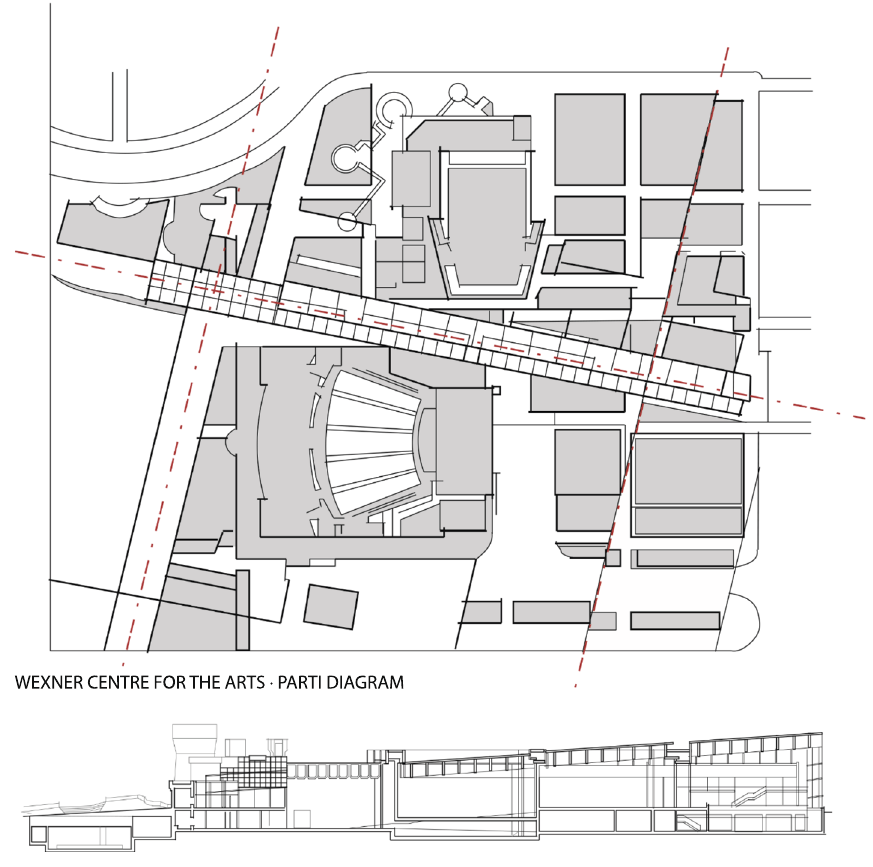
Fig. 4 OSU campus plan c. 1998 (left) and organisation diagram and section of the Wexner Centre for the Arts (right), The Ohio State University, 1989. (Source: the